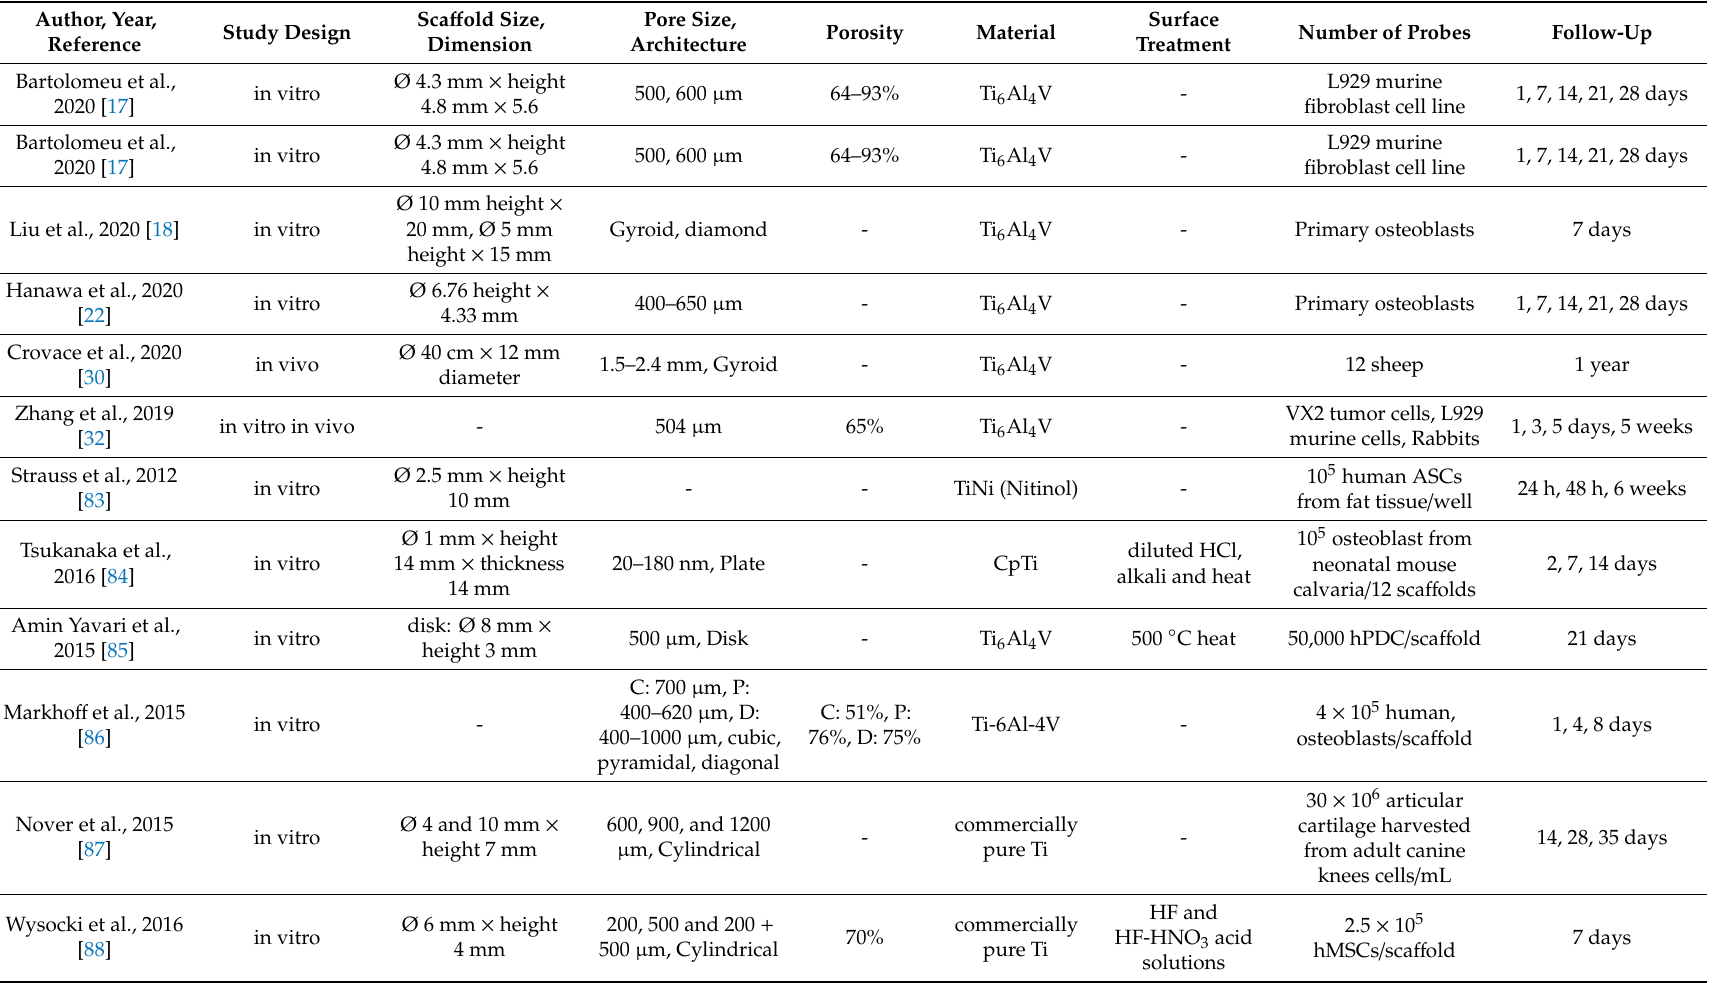
Table 1. Detailed data of the included